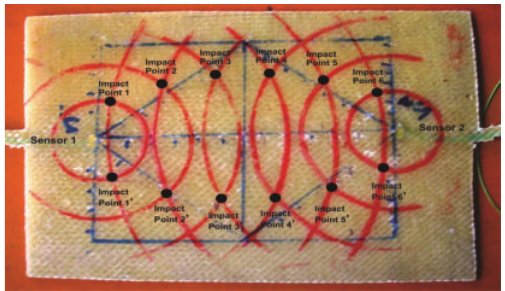
Figure 16: Impact points on the composite plate with two PZT